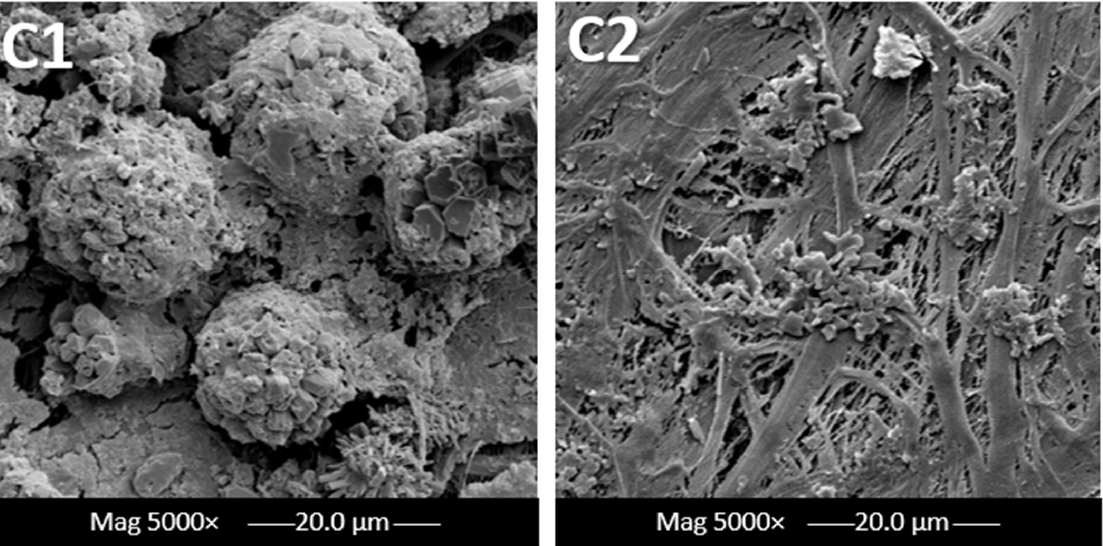
Figure 4. Magnified SEM images for PE membranes after 100 h at different concentrations immedi- ately after pilot-scale MD tests.